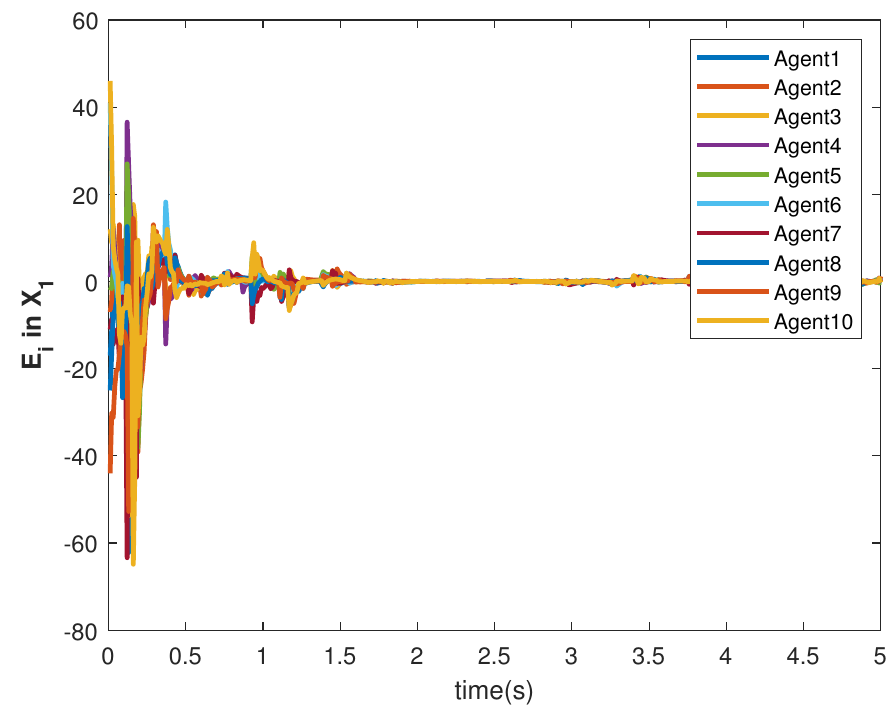
Figure 19. Consensus error E i in state X 1 of agents.